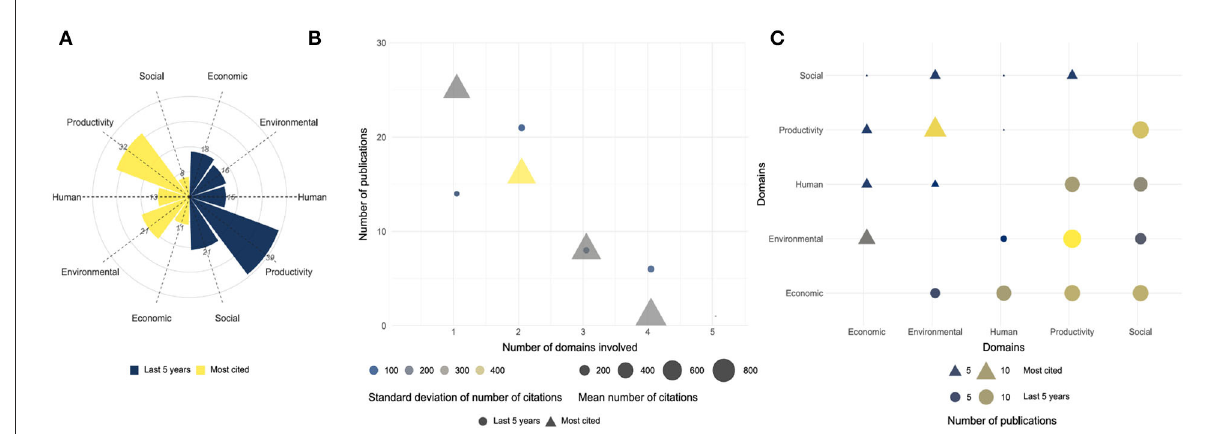
FIGURE1 In a literature review capturing the 50 most highly cited and the 50 in the past 5 years, we show (A) the number of publications of each domain for the past 5 years (dark blue) and most cited (yellow); (B) the number of publications out of the 100 reviewed (y axis) plotted against the number of domains represented in each paper (x axis); and (C) the five different domains are plotted along a matrix, with the number of publications capturing multiple domains represented by the size and color of the symbol (yellow for most cited, black for publications from the past 5